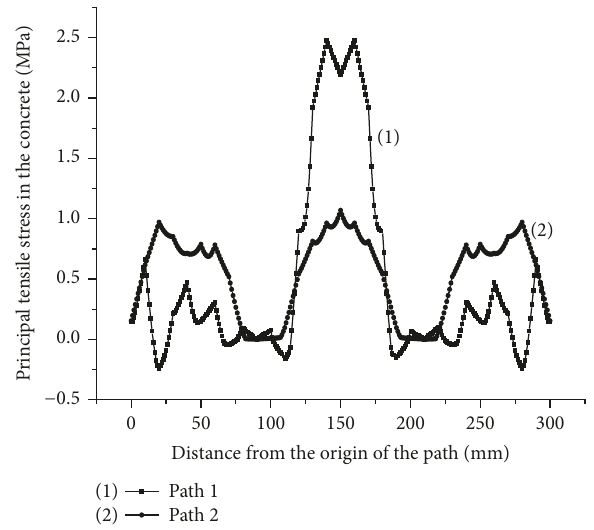
Figure 7: Distribution of the principal tensile stress along the edges of the protective cover layer.